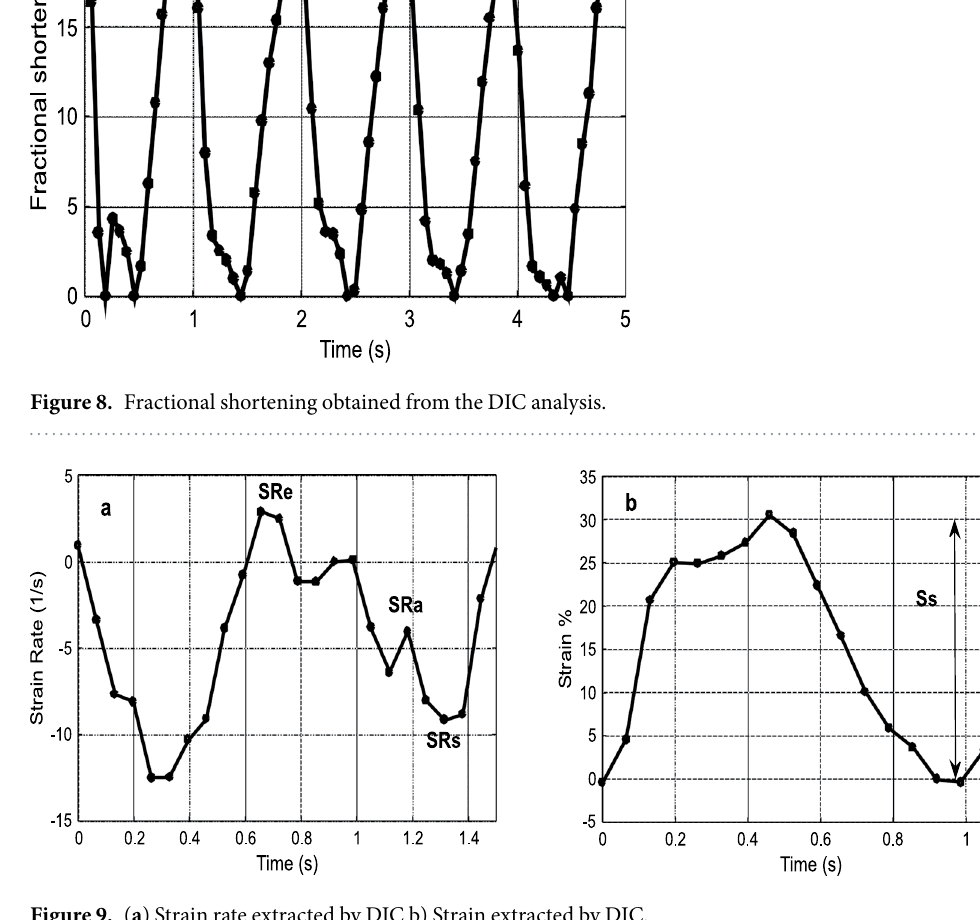
Figure 9. ( a ) Strain rate extracted by DIC b) Strain extracted by